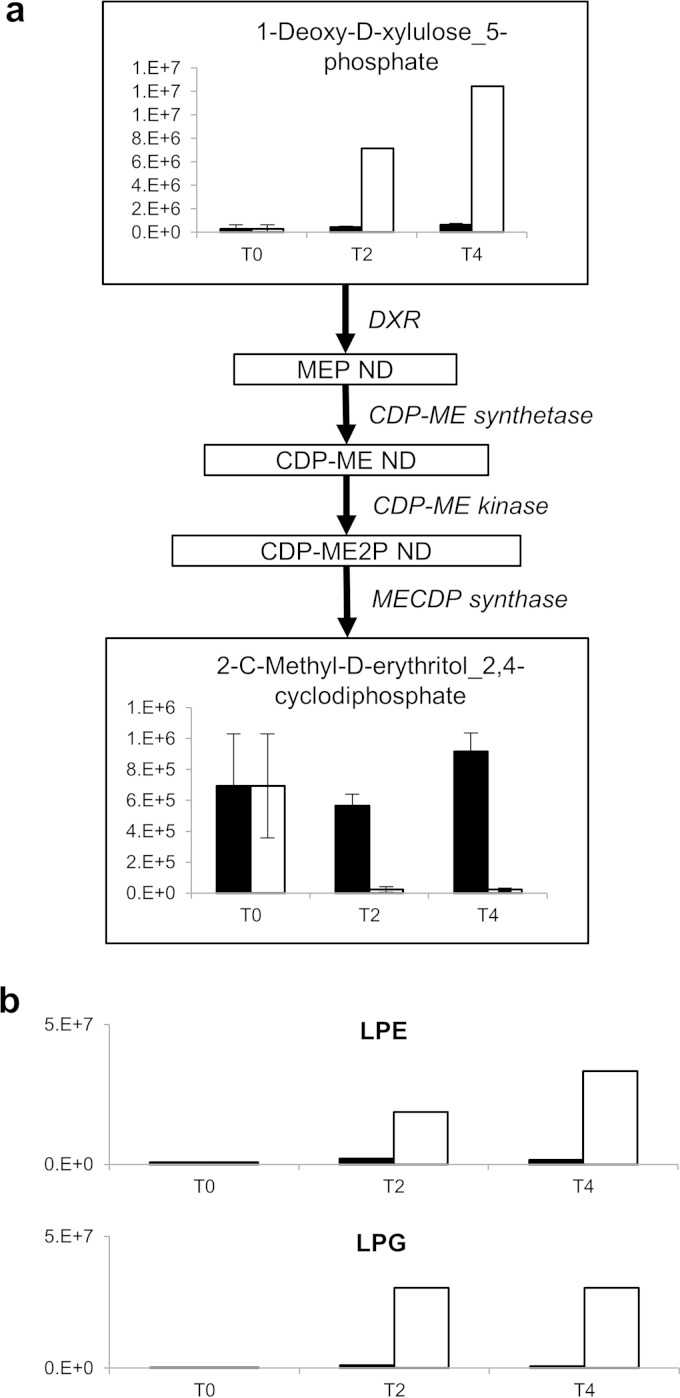
The modes of action of fosmidomycin (a) and CHIR-090 (b) were detectable by metabolomics. ND, not detected; DXR, DXP reductoisomerase; MEP, methylerythritol phosphate; ME, methylerythritol; ME2P, methylerythritol cyclodiphosphate. Black bars, no-drug control; white bars, drug treated. The y axis shows metabolite intensity, and the x axis shows hours after drug addition. Error bars show standard deviations of the mean.